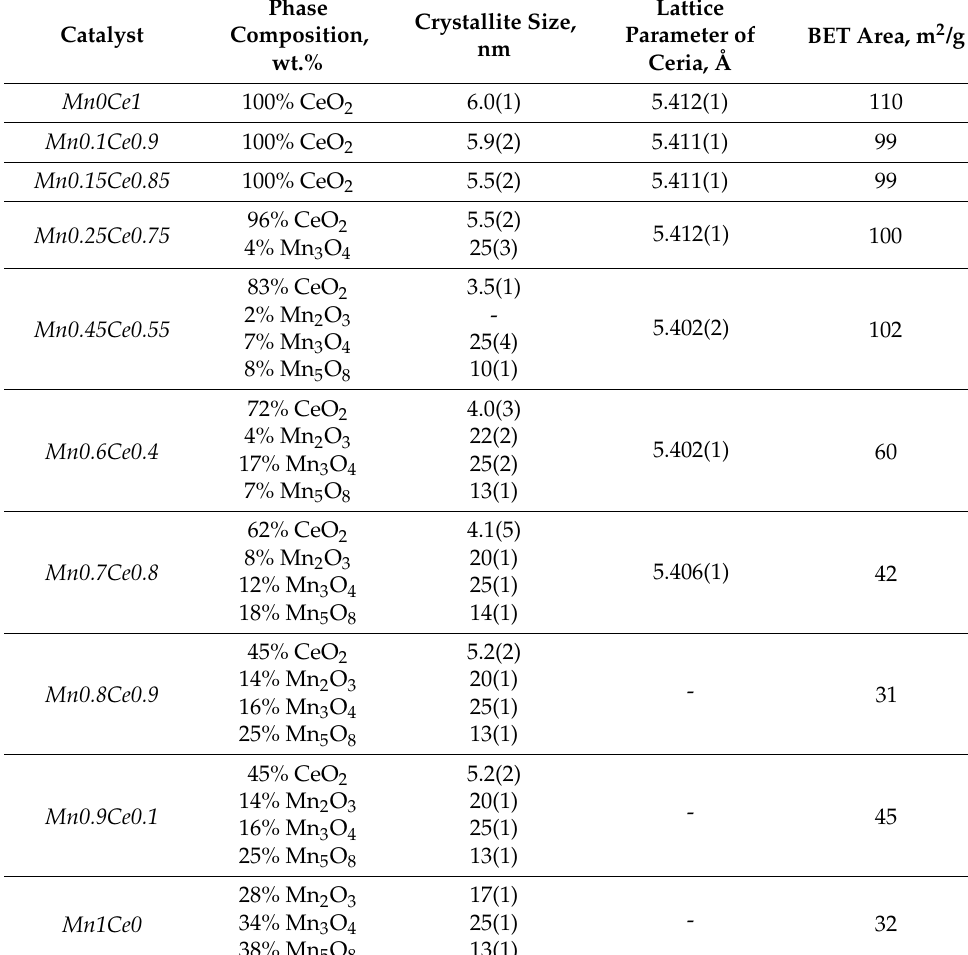
Table 1. Structural and microstructural characteristics of the MnxCe1 − x